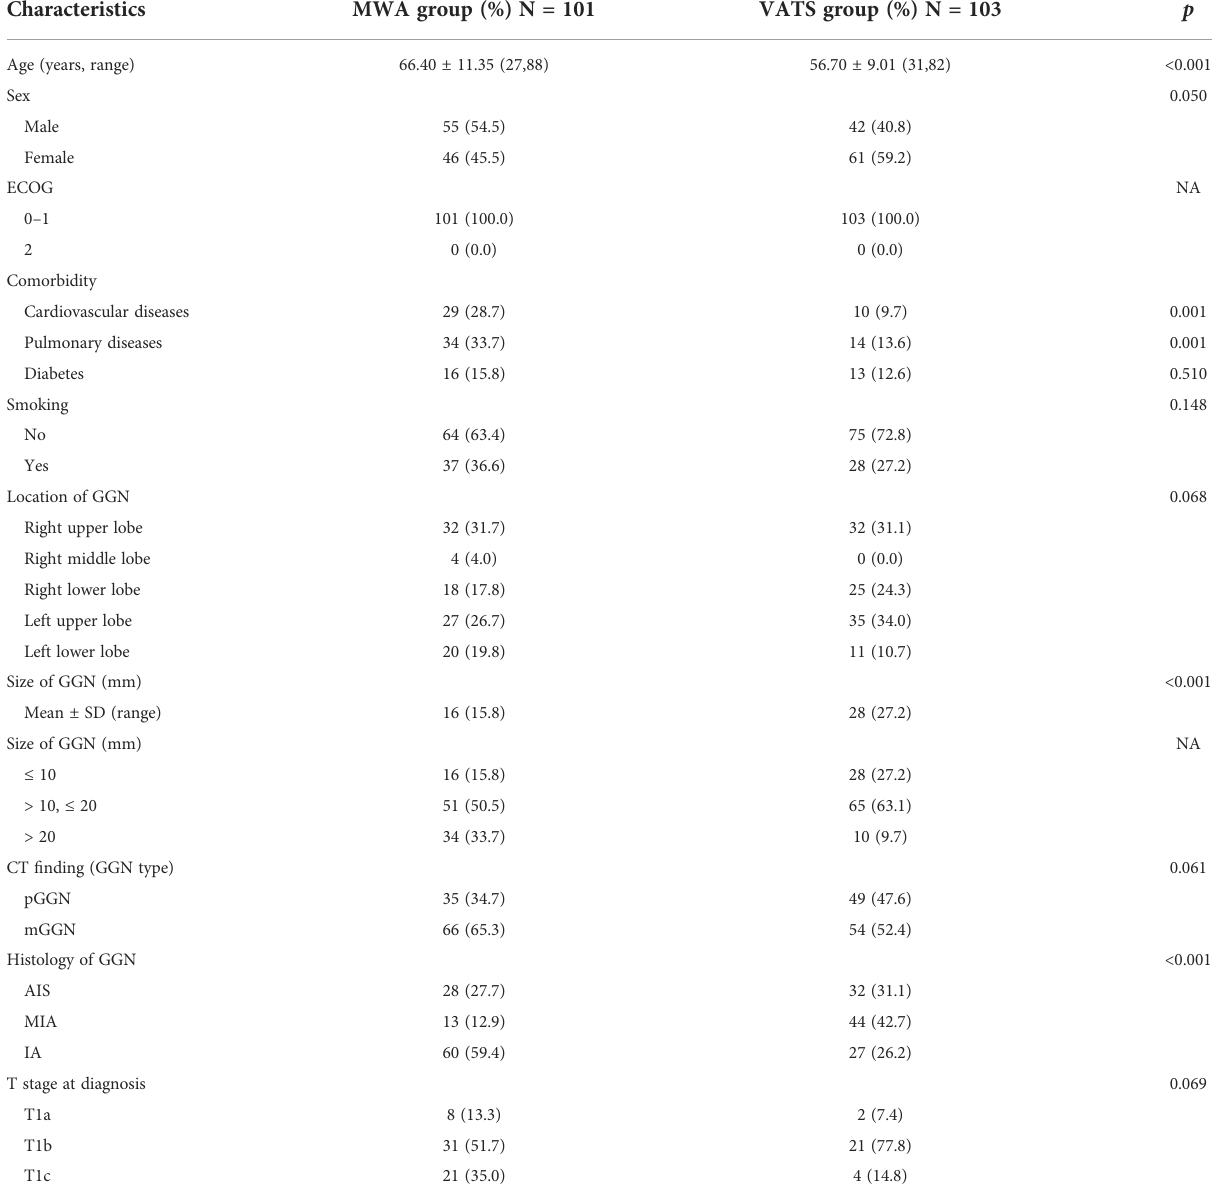
TABLE 1 Baseline characteristics of enrolled patients.